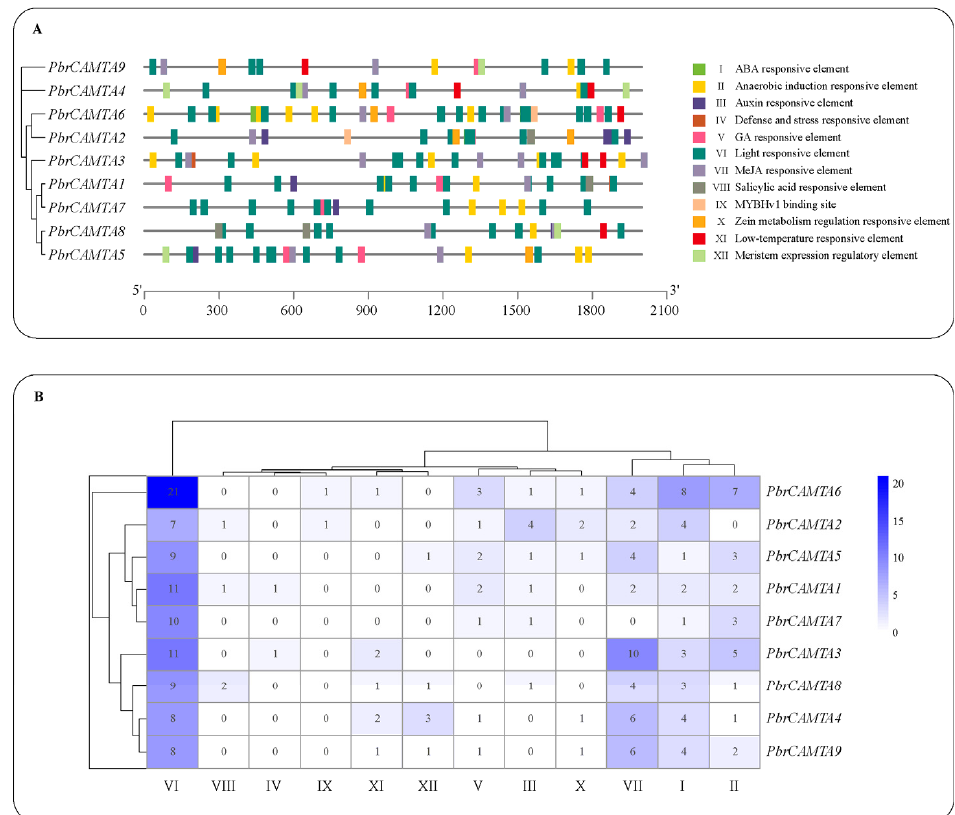
Figure 5. Cis-acting elements in putative promoters (2000 bp upstream) of PbrCAMTA genes in Chinese white pear. ( A ) Distribution of cis-acting elements on putative promoters of PbrCAMTA genes. The phylogenetic tree of the PbrCAMTA genes family was constructed by using iqtree using the neighbor-joining (NJ) method and 1000 bootstraps. ( B ) The number of cis-acting elements on putative promoters of PbrCAMTA genes. A total of twelve cis-acting elements are investigated, including: (I) ABA-responsive elements, (II) Anaerobic induction-responsive elements, (III) Auxin- responsive elements, (IV) Defense-and-stress-responsive elements, (V) GA-responsive elements, (VI) Light-responsive elements, (VII) MeJA-responsive elements, (VIII) Salicylic-acid-responsive elements, (IX) MYBHv1 binding sites, (X) Zein metabolism-regulation-responsive elements, (XI) Low- temperature-responsive elements, and (XII) Meristem expression regulatory